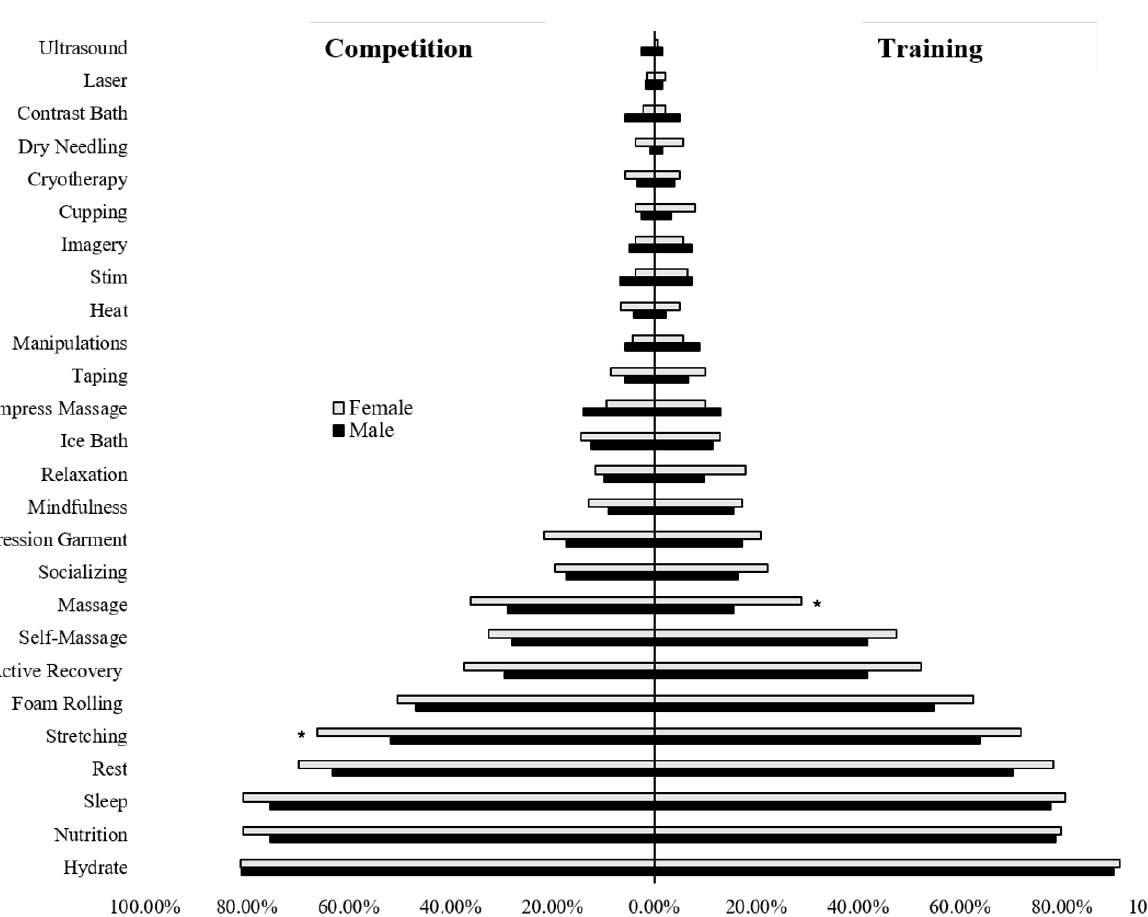
Figure 1. Recovery strategy use in training and competition by sex . Note. * = p < 0.05. Individuals who reported placing top three overall in competition used significantly more recovery strategies than those who had not placed in the top three overall for both training (8.8 ± 3.9 vs. 6.8 ± 3.2; p < 0.001, d = 0.61, d 95%CI = 0.30, 0.91) and competition (7.6 ±